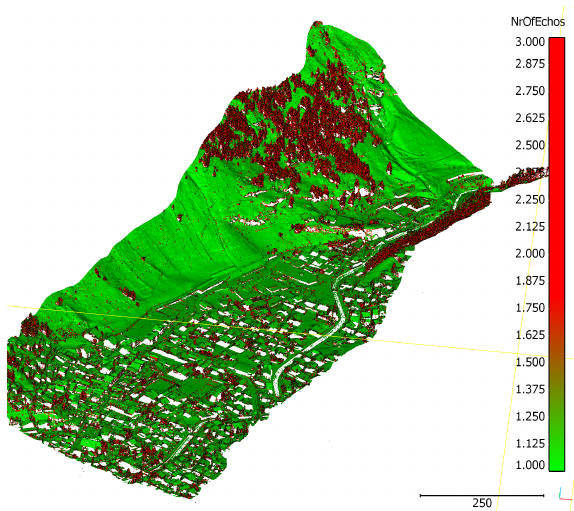
Figure 2: ALS point cloud of the town of Zermatt (canton of Valais, Switzerland), view towards North-West; green: single echoes, red: two or more echoes per